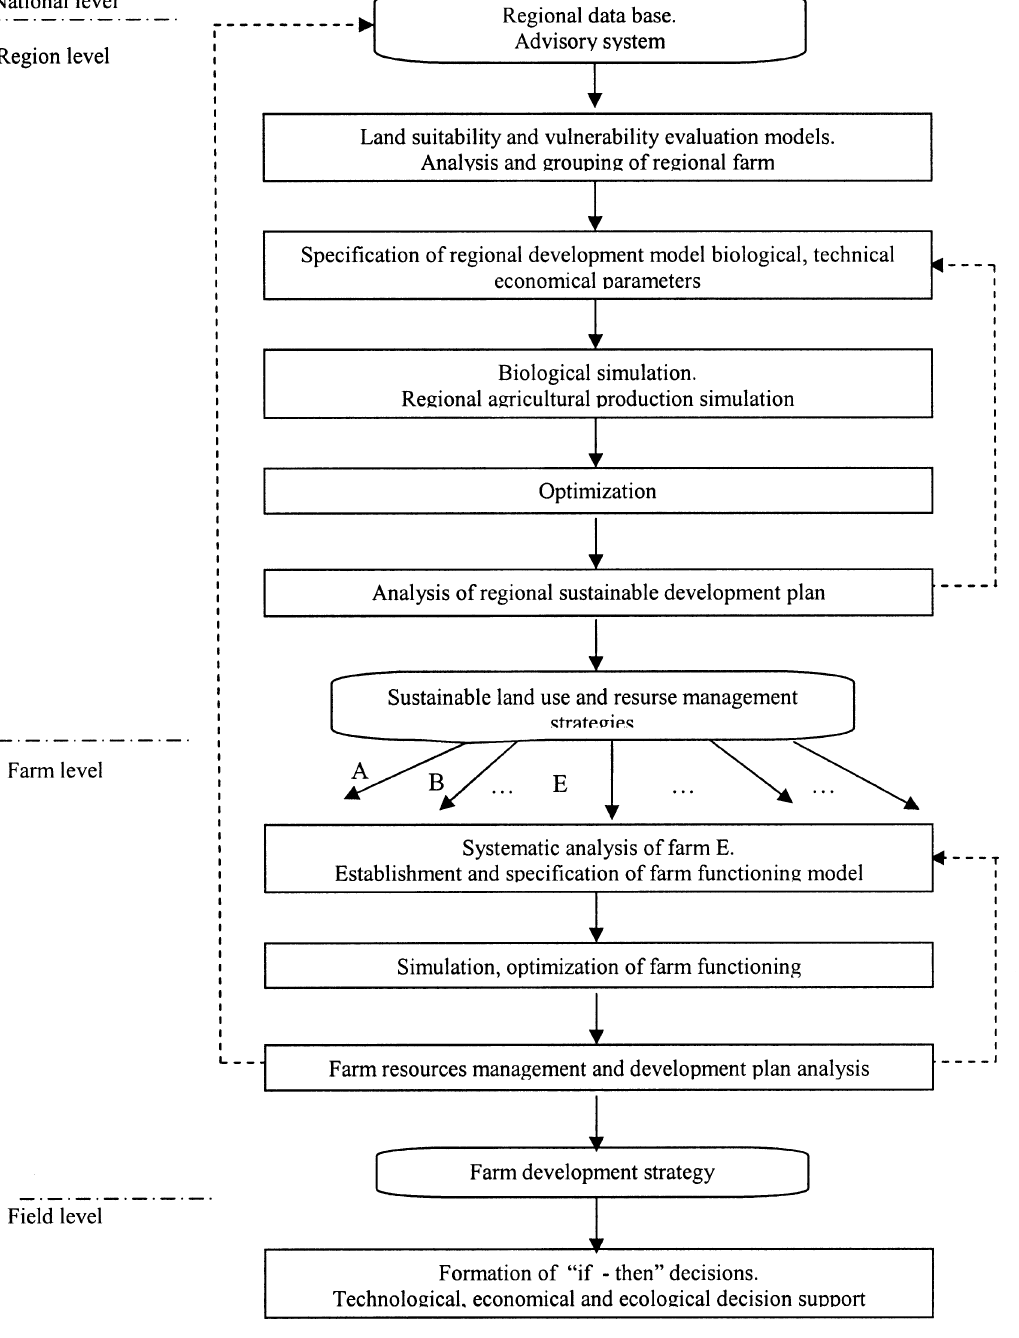
5%((cid:30)(cid:5)$(cid:30)(cid:5)